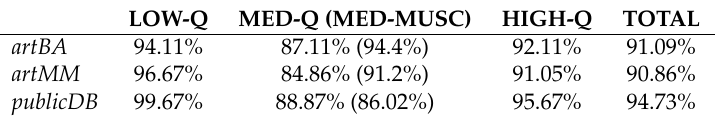
Table 2. Detection accuracy values obtained for each class of contaminated segments (LOW-Q, MED-Q and HIGH-Q) in the three datasets ( artBA , artMM , publicDB ). For MED-MUSC segments, accuracy is computed on EEG segments classified as MED-Q by the Weighted